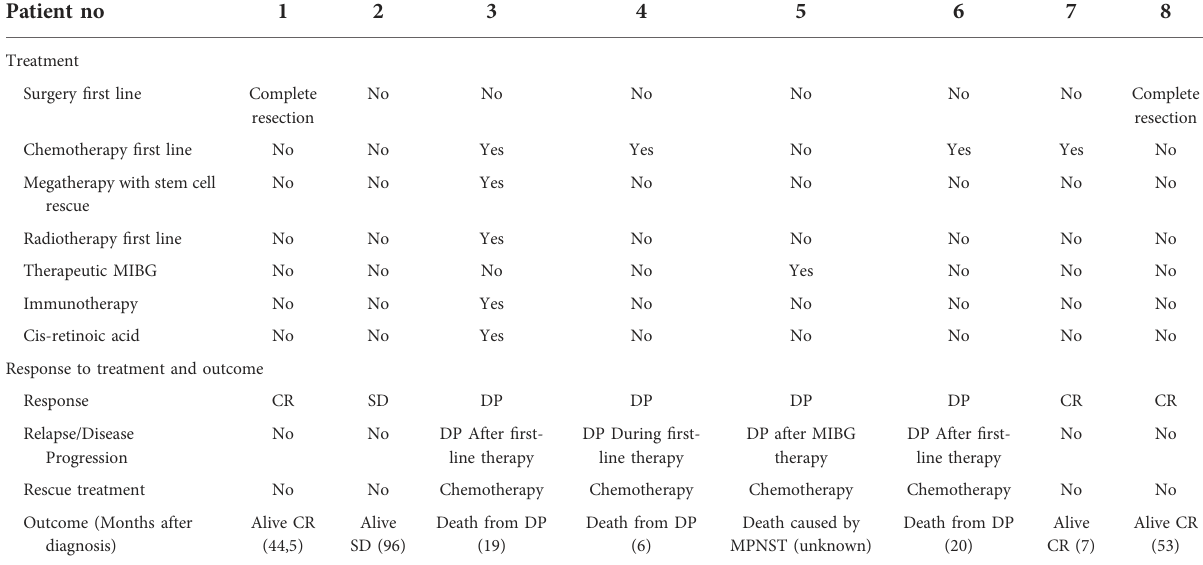
TABLE 4 Treatment details and outcome for eight patients. Patient